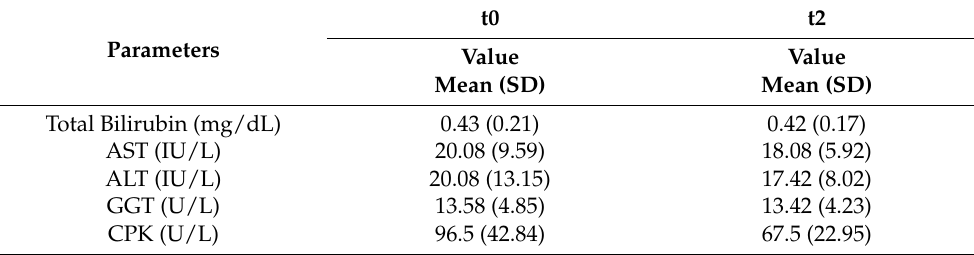
Table 6. Descriptive statistics for each safety blood parameter measured at baseline (t0) and after 60 days (t2) of